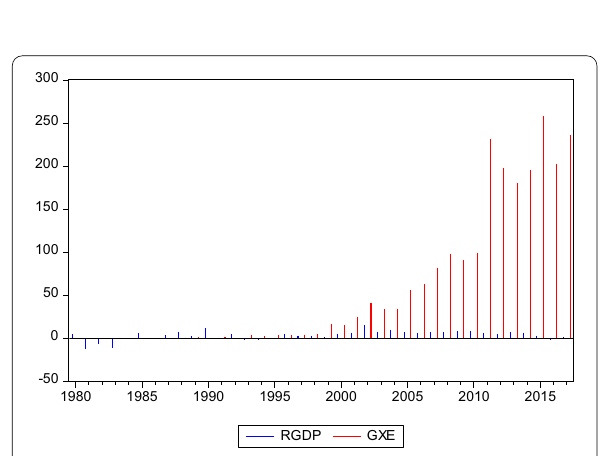
Fig. 2 The trends between real gross domestic products, student enrolment and government